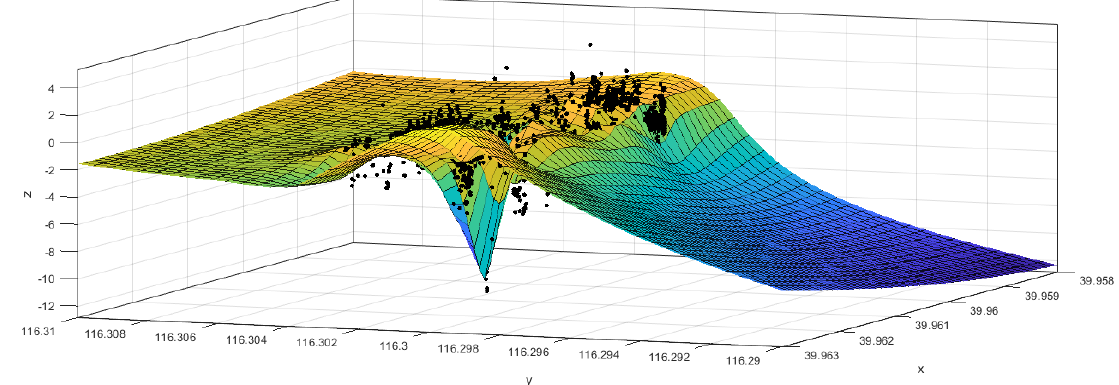
Figure 7. Fitting result using thin-plate spline interpolation method.